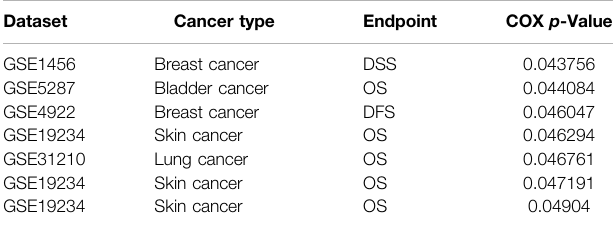
TABLE 4 | ( Continued ) The prognosis of IQGAP3 in pan-cancer analysis by using the prognostic database.